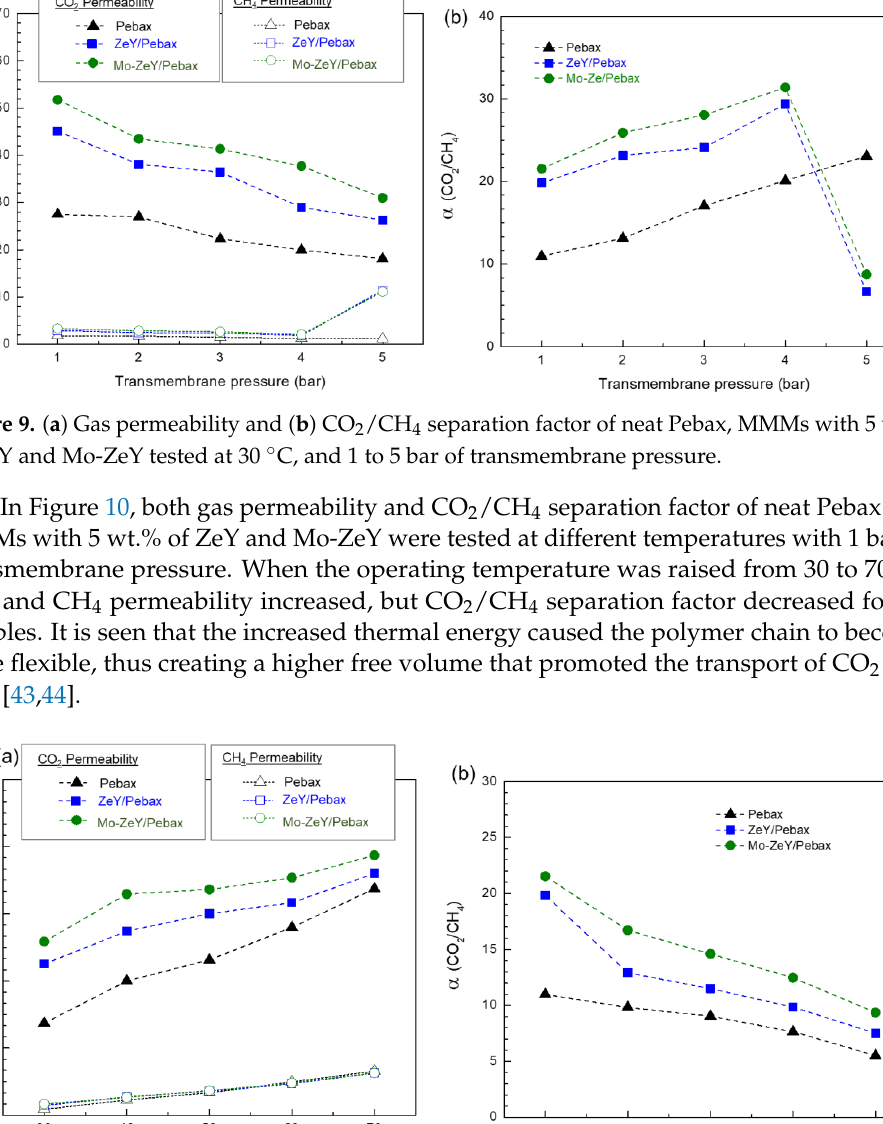
Figure 10. (a) Gas permeability and (b) CO 2 /CH 4 separation factor of neat Pebax and MMMs with 5 wt.% of ZeY, and Mo-ZeY tested at 1 bar of transmembrane pressure and 30 to 70 °C.